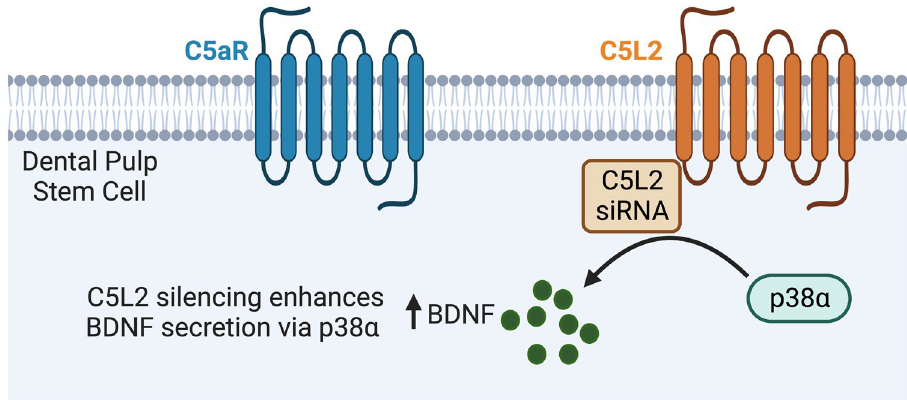
Figure 6. Summarized effects of C5L2 silencing on DPSCs. C5L2 siRNA treatment enhances BDNF secretion via increased phosphorylation of p38α to promote nerve